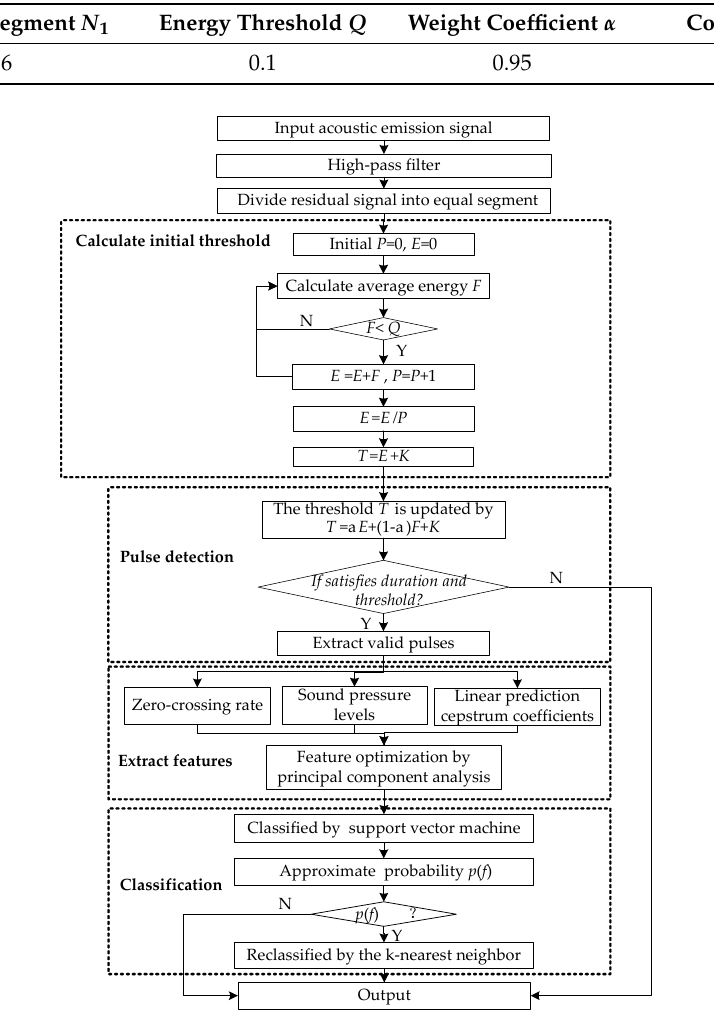
Figure 4. The general block diagram of the proposed method.